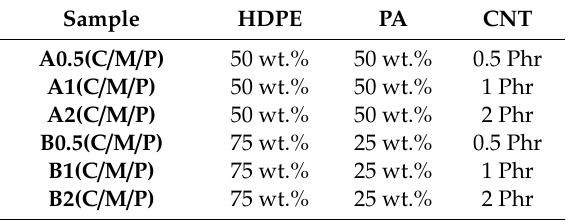
Table 1. Compositions and designation of HDPE / PA / CNT